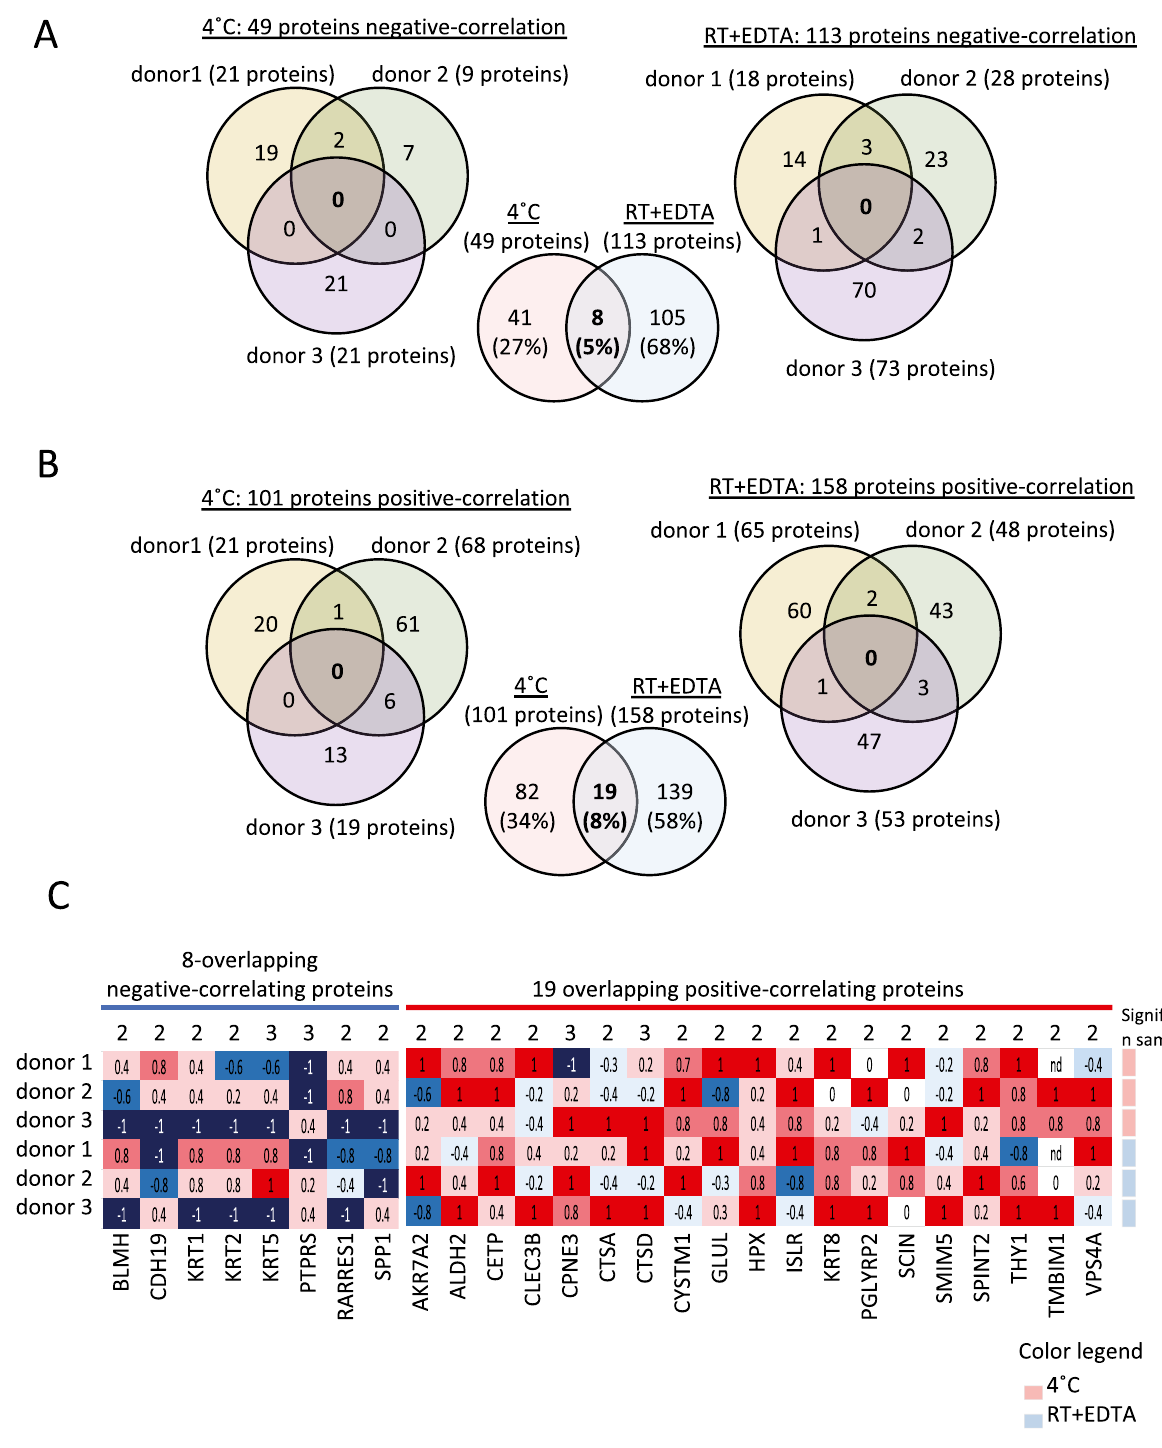
Figure 3. Time dependent effect of short-term urine storage on the global urinary EV proteome. ( A ) Venn diagrams showing proteins that are showing a significant negative correlation (Rho-correlation analysis) over time between the three donors for samples stored at 4 °C or at RT + EDTA. A limited number of donor- unique proteins that are decreased in time, with only eight proteins in overlap to be downregulated in urine samples stored at 4 °C and at RT + EDTA. ( B ) Venn diagrams showing proteins that are showing a significant positive correlation over time (Rho-correlation analysis) between the three donors for samples stored at 4 °C or at RT + EDTA. Of all positive correlating proteins, 19 were in overlap in urine samples stored at 4 °C and at RT + EDTA. ( C ) Heatmap analysis showing the rho values and the number of samples in which the correlation was found to be significant for the 8 negative and 19 positive correlating proteins. No consistency was observed between the samples and the proteins towards the positive or negative